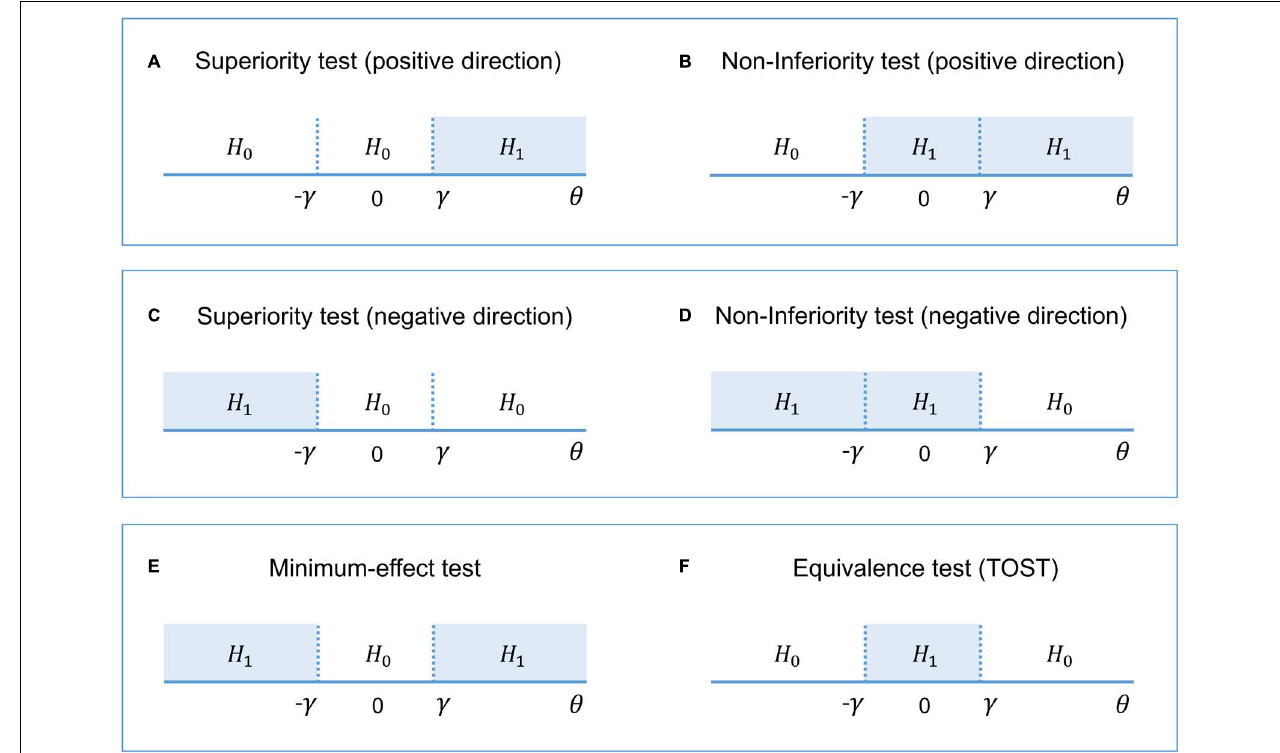
FIGURE 2 | The alternative ( H 1 ) and null ( H 0 ) hypotheses for different types of interval-null hypotheses tests. (A,B) One-sided tests in the positive direction (‘the larger is better’). (C,D) One-sided tests in the negative direction (‘the smaller is better’). (E) Combination of both superiority tests. (F) Combination of both non-inferiority